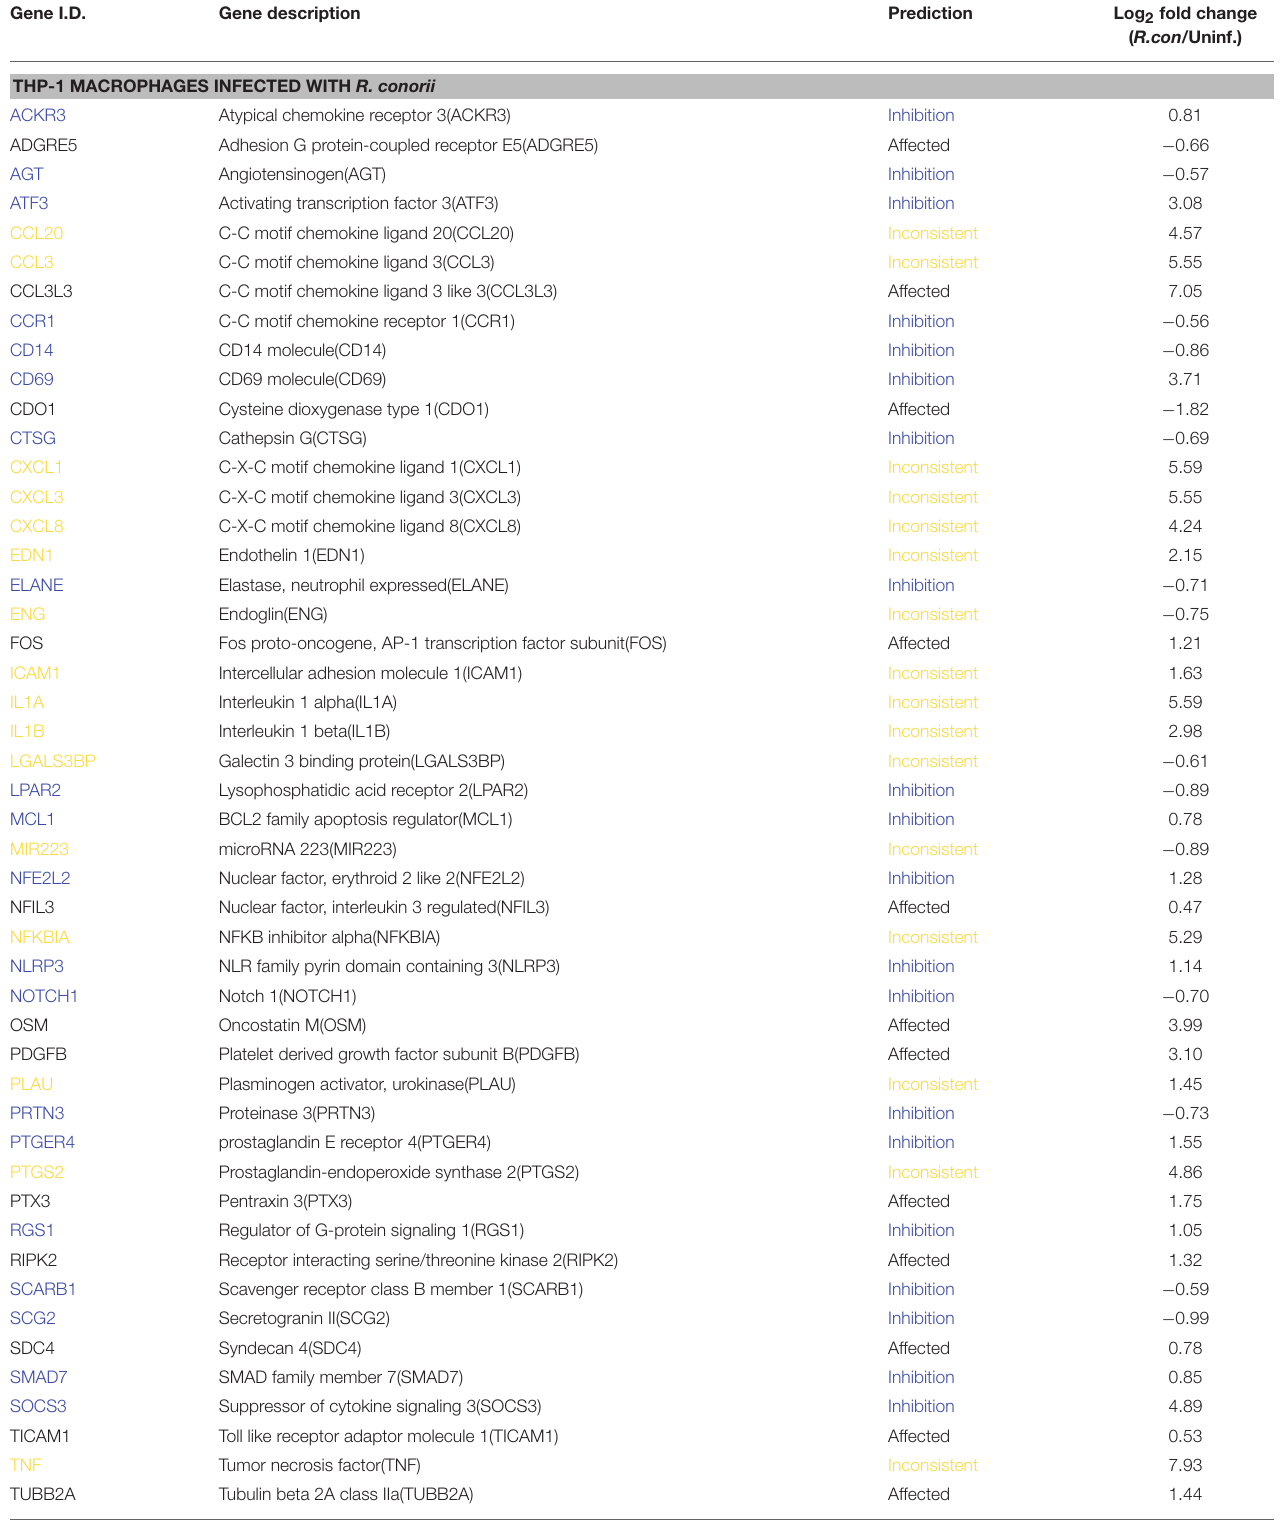
TABLE 3 | Predicted contribution of DE genes in R. conorii - and R. montanensis -THP-1 macrophages for inflammatory response based on “Diseases and Functions” category by IPA. Gene I.D. Gene description Prediction Log 2 fold change